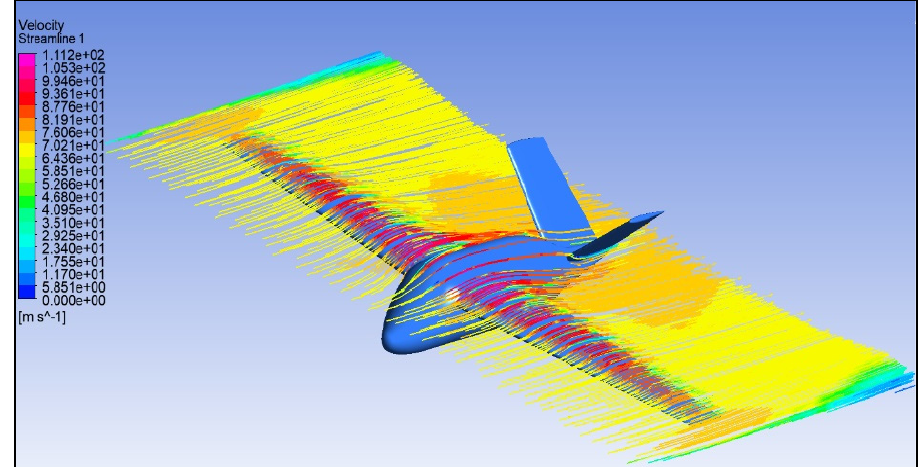
Figure 30. Velocity streamline at XY plane.